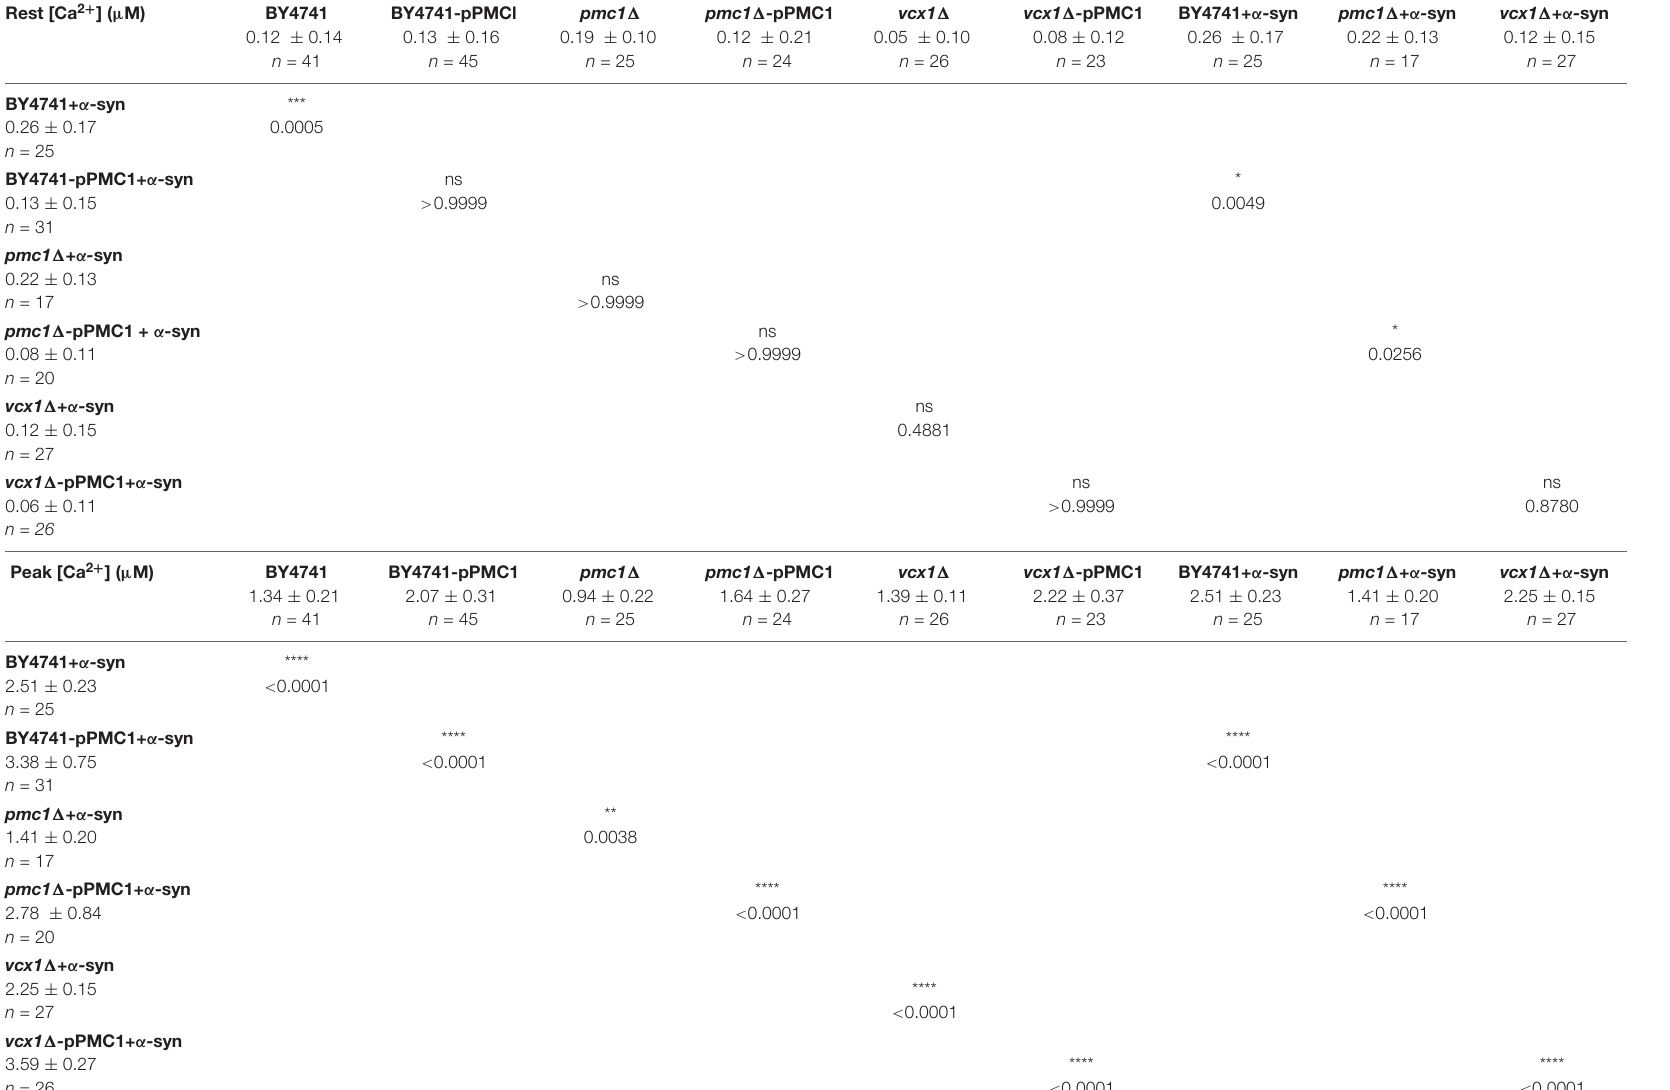
TABLE 5 | [Ca 2 + ] in determined at the end of the Ca 2 + -free period (Rest [Ca 2 + ]) (before membrane permeabilization) and the peak amplitude of the Ca 2 + release transient (Peak [Ca 2 + ]) in BY4741 yeast strains at 30 ◦ C. Rest [Ca 2 + ] ( µ M) BY4741 BY4741-pPMCl 0.12 ± 0.14 0.13 ± 0.16 n = 41 BY4741+ α -syn 0.26 ± 0.17